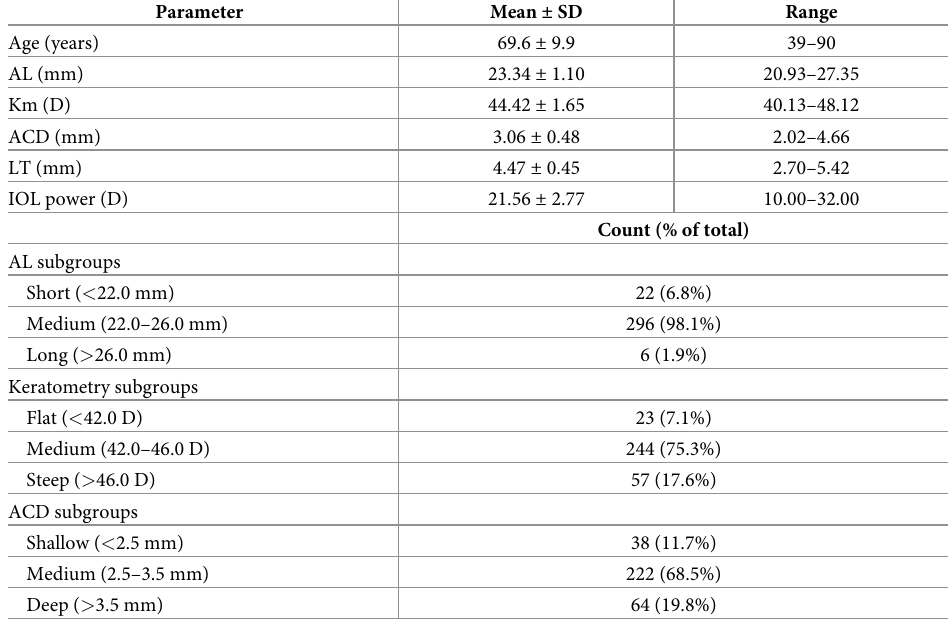
Table 1. Demographics and biometric data using a single optical biometry device (IOLMaster 700) in the patients who underwent cataract surgery (n =